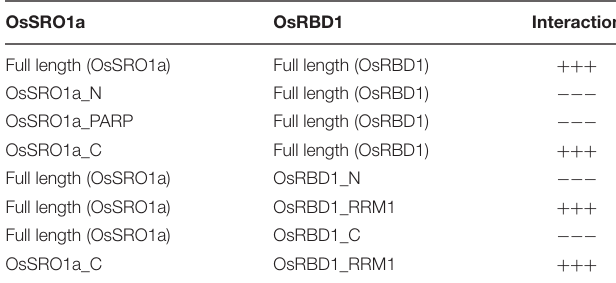
TABLE 1 | Summary of interaction between different domains of OsSRO1a and OsRBD1. OsSRO1a OsRBD1 Interaction